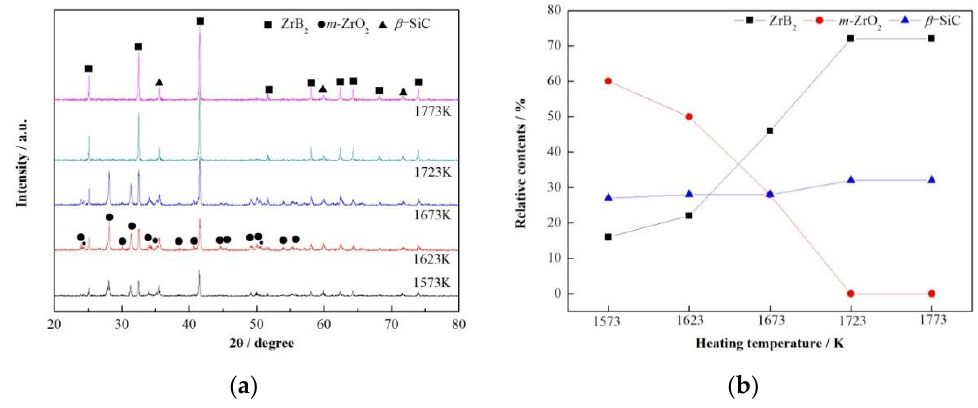
Figure 2. Phase composition of sample ZS2 heated at 1573–1773 K for 3 h, n (Fe): n (NaCl): n (ZrSiO 4 ): n (B 2 O 3 ): n (C) = 0.2:0.5:1:1.5:8.4. ( a ) XRD patterns; ( b ) relative contents of the crystalline phase.